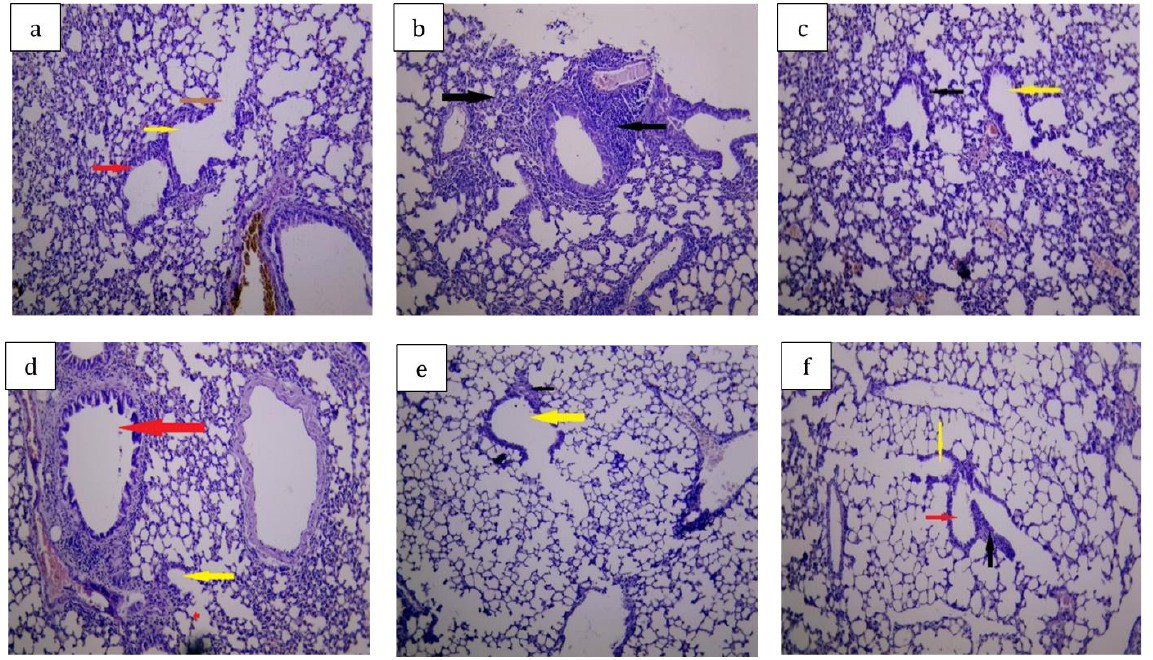
Figure 1. Effect of Ammi majus alcoholic extract on histopathological appearance of lung tissue for ovalbumin-induced asthma in mice (H&S, 40×). a, Group I served as a negative control and received distilled water; b, Group II received ovalbumin; c, Group III received Ammi majus at 64 mg/kg/day with sensitization; d, Group IV received Ammi majus at 128 mg/kg/day with sensitization; e, Group V received Ammi majus at 64 mg/kg/day without sensitization; f, Group VI received Ammi majus at 128 mg/kg/day without